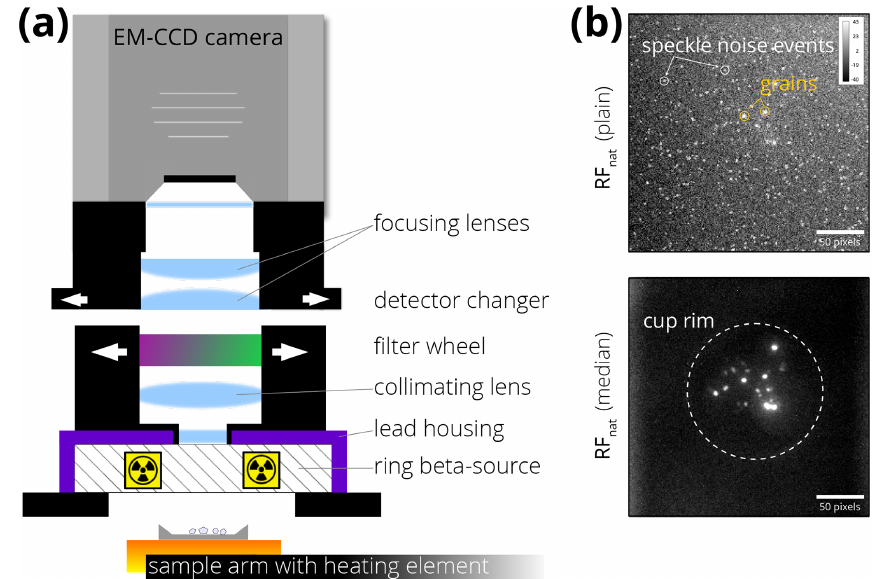
Figure 1. (a) Technical sketch of the camera system for spatially resolved IR-RF measurements at the lexsyg research reader L2 in Bordeaux. The collimating lens position and the camera’s height were adjusted manually to obtain the best IR-RF image quality. (b) Typical image output of a natural IR-RF image stack. The upper picture shows an unprocessed but background-corrected SR IR-RF image taken with high SNR setting (see Table 2). Two speckle noise events caused by bremsstrahlung (white) and two grain IR-RF signals (yellow) are marked. Individual grain signals are hardly distinguishable from the image noise. The lower image shows the processed image stack’s median image, where light from individual grains is visible. The dashed white line marks the rim of the sample carrier (here a stainless-steel